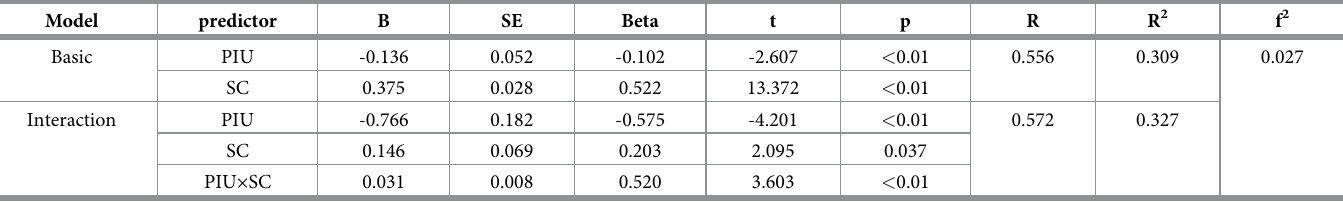
Table 4. Basic and interaction models for assessing the moderation effect of safety climate on the relationship between problematic internet use and safety